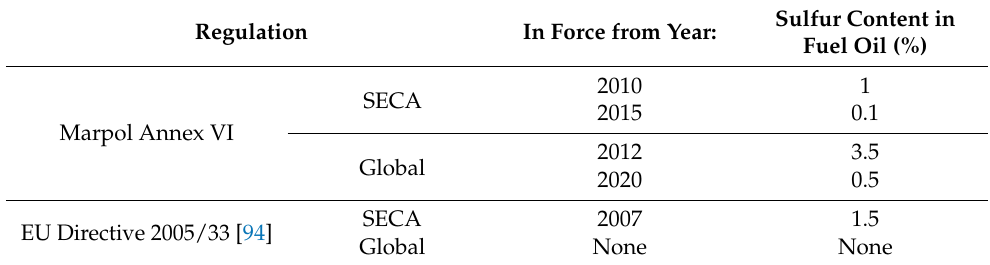
Table A4. Sulfur content in fuel.